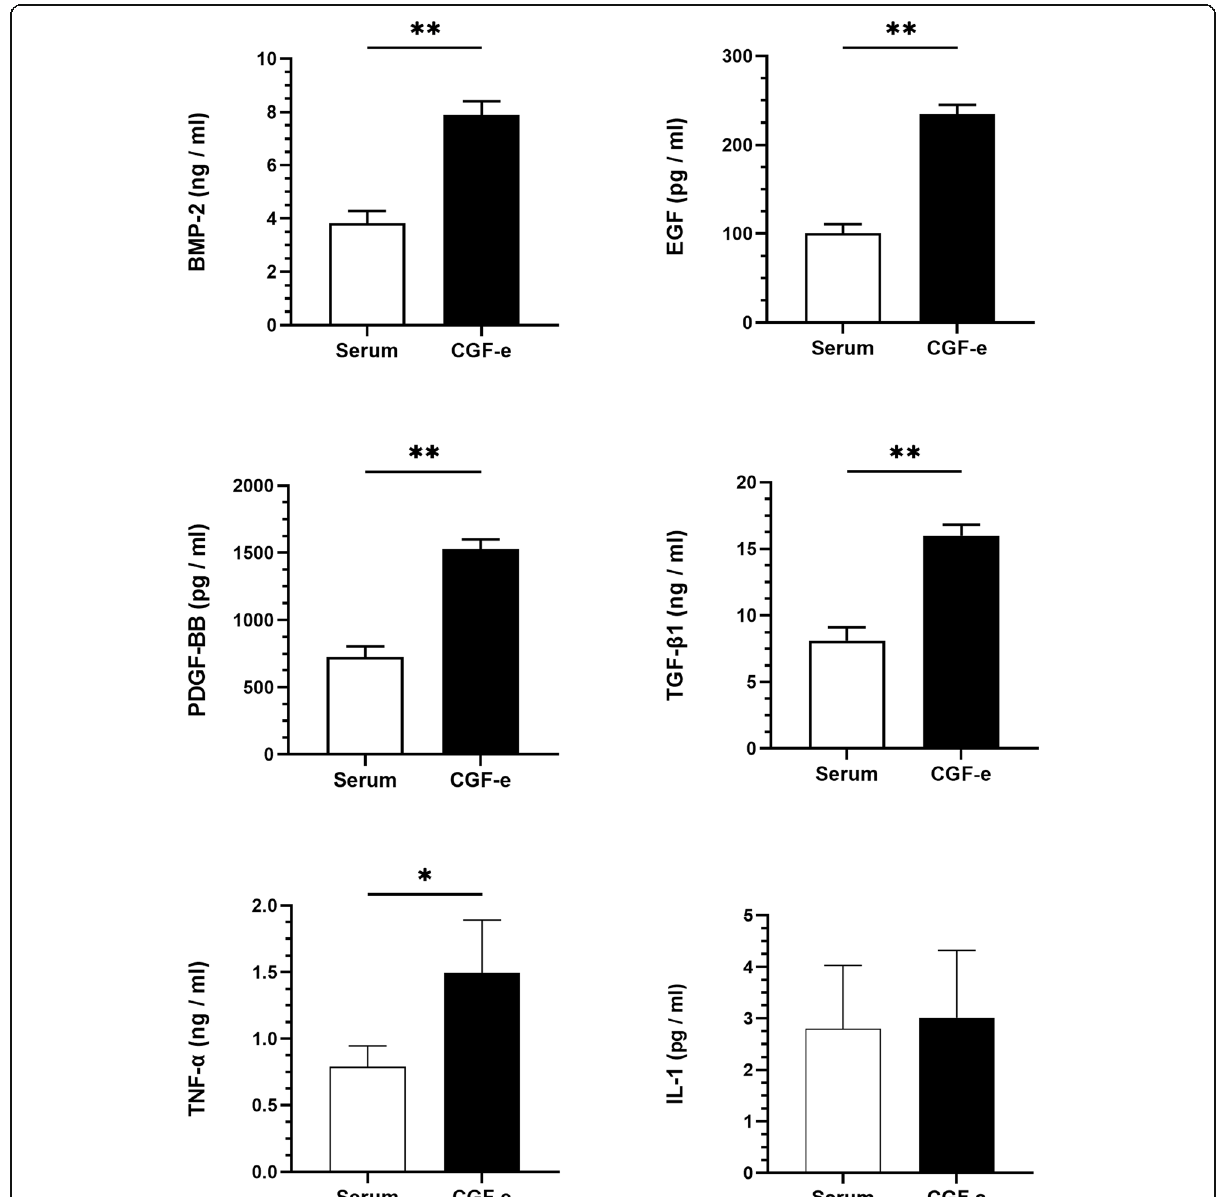
Fig. 1 Determination of growth and inflammatory factors in CGF-e and serum. * p < 0.05; ** p <